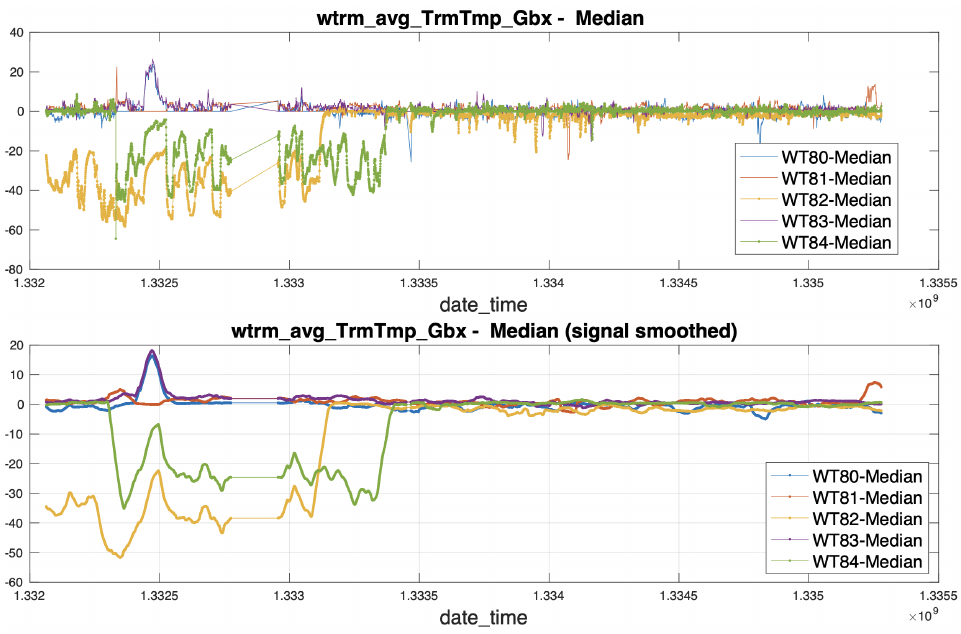
Figure 7. At the top, the residue of the signals wtrm_avg_TrmTmp_Gbx of Figure 6. The same signals smoothed by a 50-sample moving average filter are depicted at the bottom.